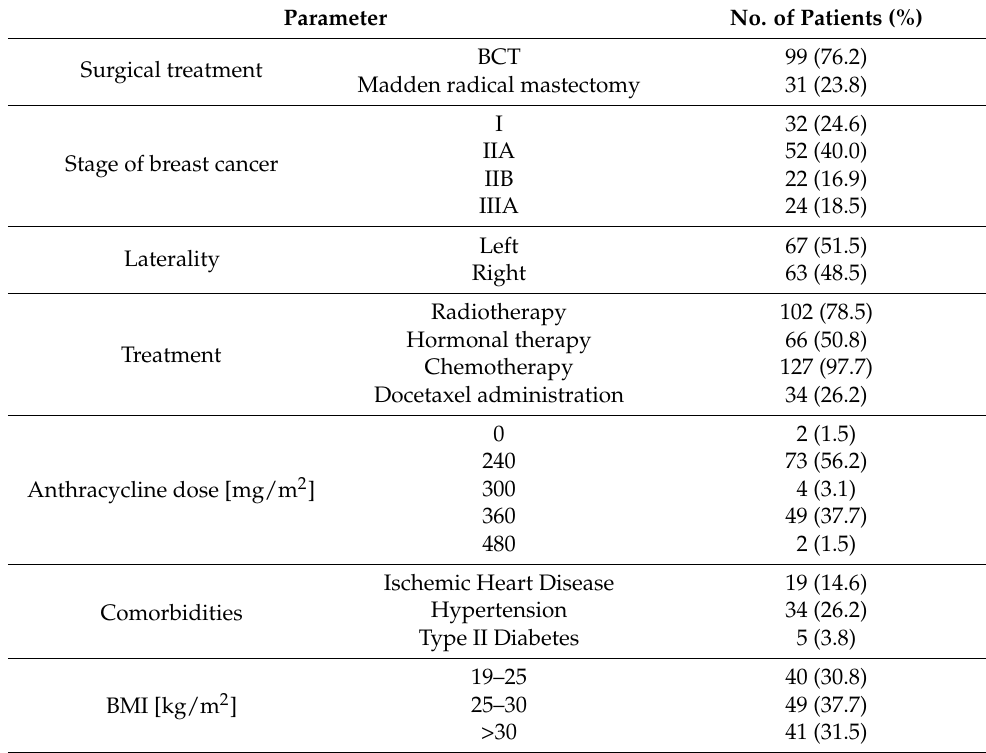
Table 1. Patients’ baseline